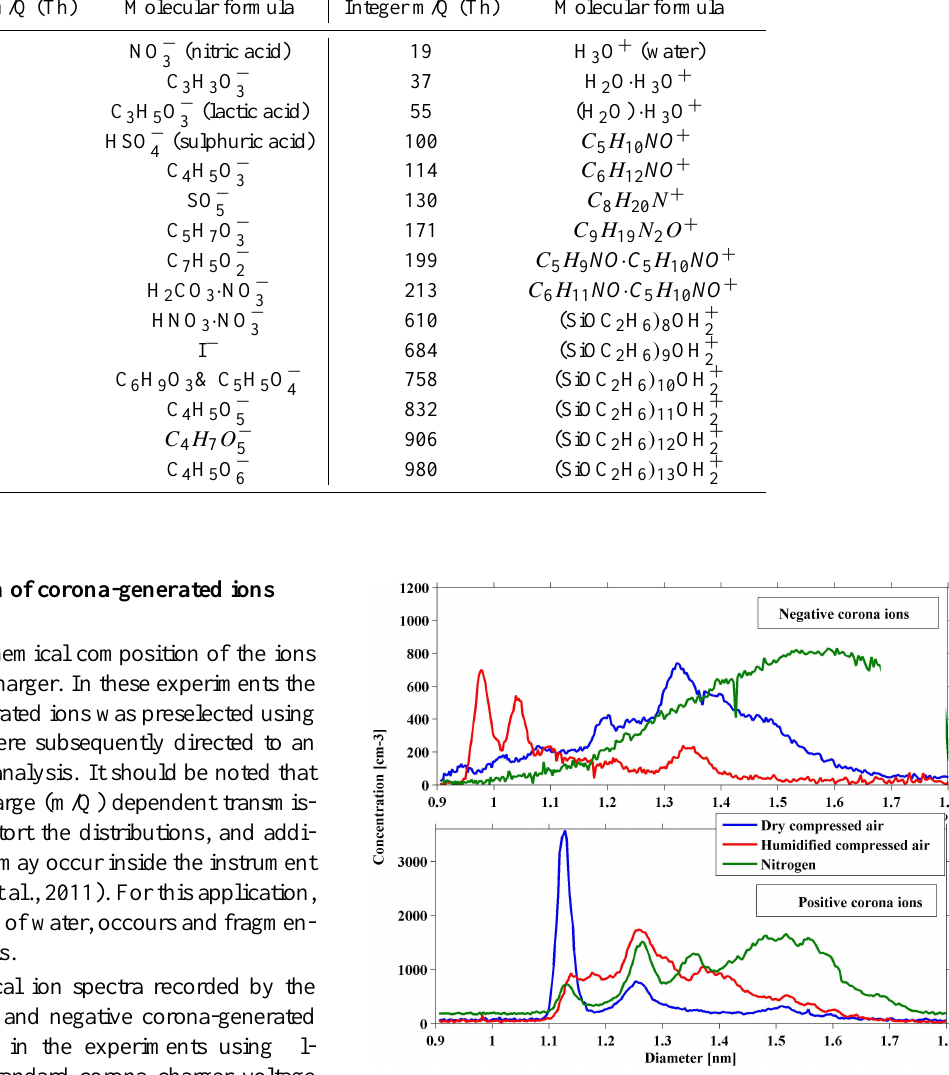
Fig. 6. Size distribution of negative and positive ions generated by the corona discharge with different sample (carrier) gas mixture. The corona voltage was ±